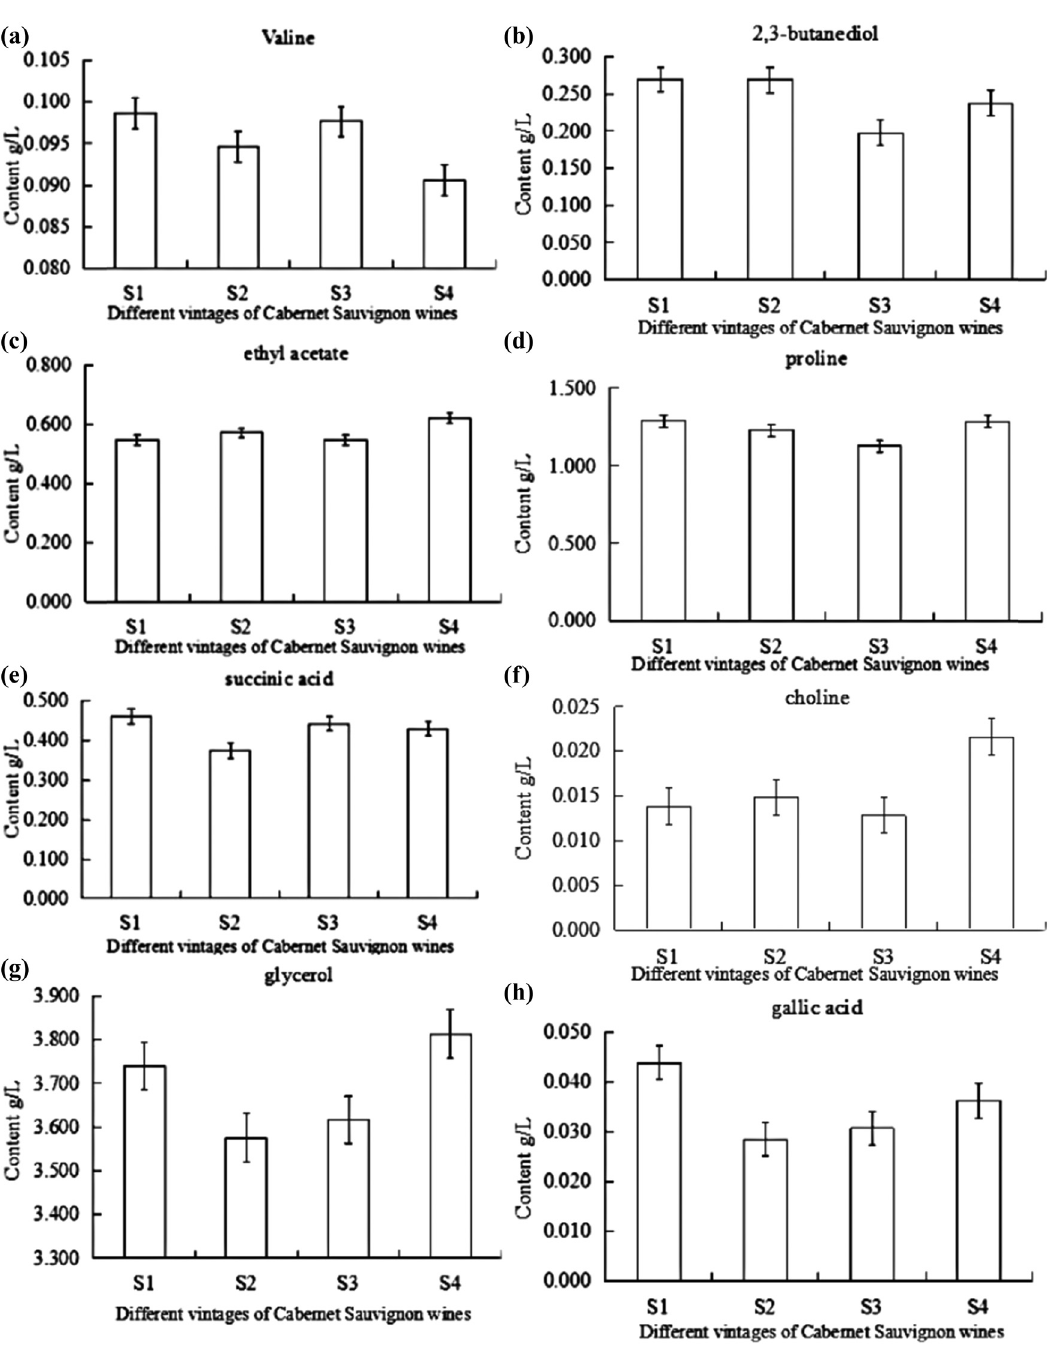
Figure 21: Comparison of the main metabolite concentrations in the 2009 – 2012 vintage wines. *The error bars indicate the standard deviations. S1, S2, S3, and S4 represent 2009, 2010, 2011, and 2012 vintages of Cabernet Sauvignon wines, respectively. ( a ) : Valine content; ( b ) : 2,3 - butanediol; ( c ) : ethyl acetate; ( d ) : proline; ( e ) : succinic acid; ( f ) : choline; ( g ) : glycerol; ( h ) : gallic